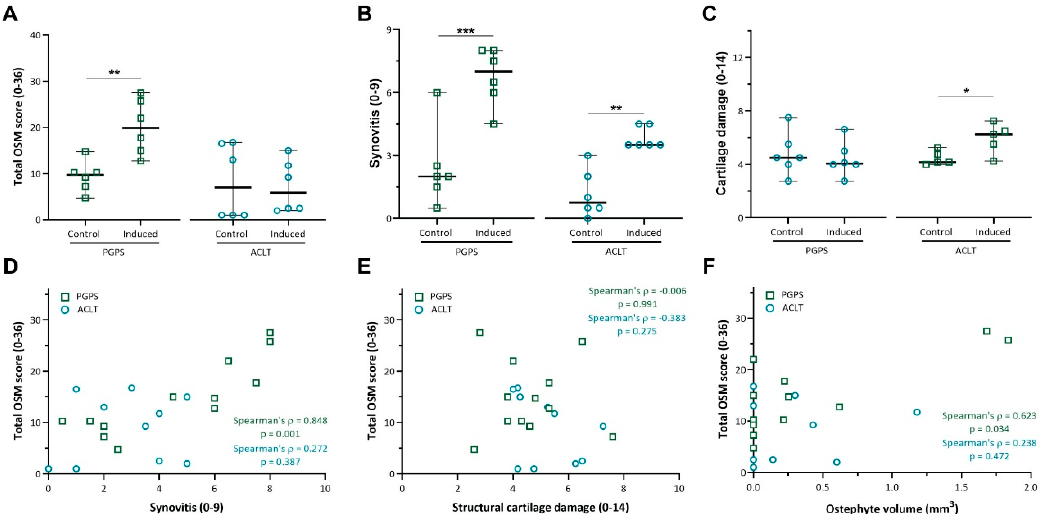
Figure 4. Total OSM expression and correlation with synovitis, cartilage damage and osteophyte volume. ( A ) Total OSM score was calculated by adding up the individual scores for every compartment (min = 0; max = 32). ( B ) Synovitis was scored according to the Krenn score. ( C ) Cartilage damage was scored according to the Mankin score. Data are presented as median and 95% CI. Each individual datum point represents a rat knee. (*: p < 0.05, **: p < 0.01, and ***: p < 0.001). ( D ) Correlation scatterplot between total OSM staining and synovitis score in both PGPS and ACLT models. ( E ) Correlation scatterplot between total OSM staining and articular cartilage damage in both PGPS and ACLT models. ( F ) Correlation scatterplot between total OSM and osteophyte volume in both PGPS and ACLT models. Each individual datum point represents a rat knee.